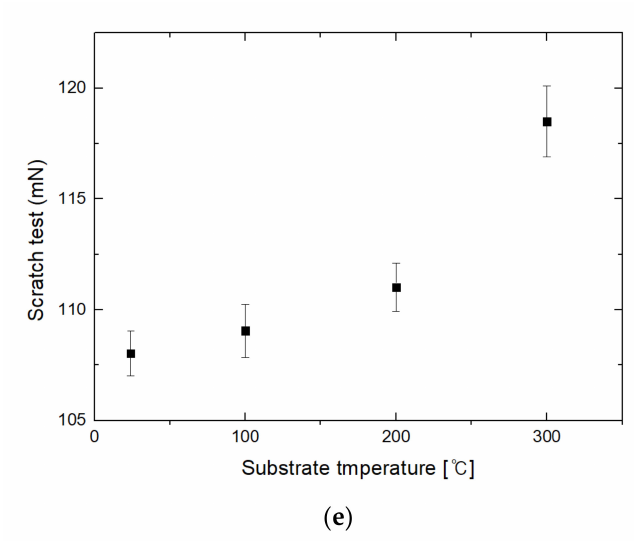
Figure 4. OM image of the nanoscratch test: ( a ) ambient temperature (~24 ◦ C); ( b ) 100 ◦ C; ( c ) 200 ◦ C; ( d ) 300 ◦ C; and ( e ) critical adhesive strengths at each temperature using the nanoscratch test are 108.03, 109.05, 111.02, and 118.5 mN, respectively.